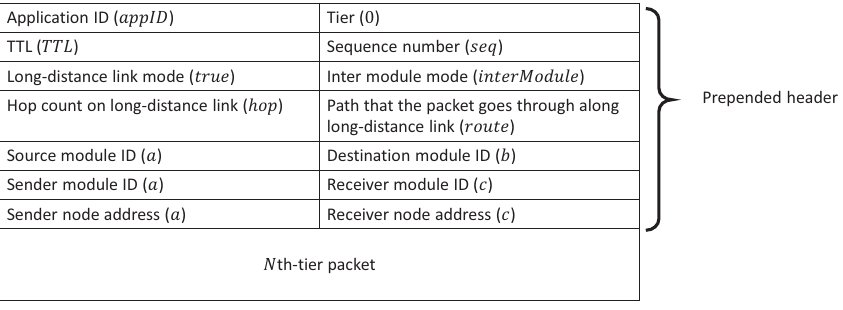
Figure A2. Packet format when the data packet exists on a virtual long-distance